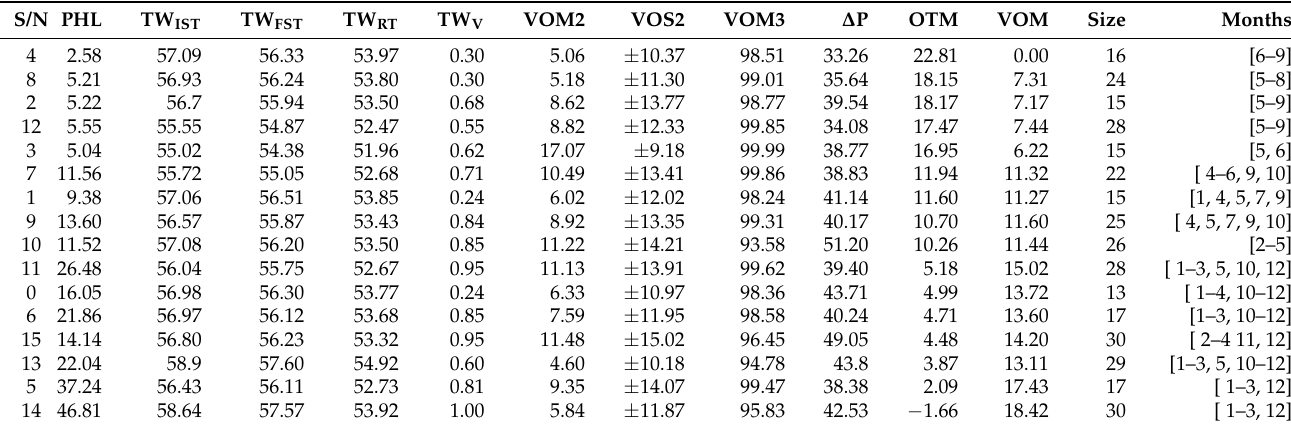
Table 14. Closed patterns from global model showing correlations between all three views after receiving chunk 2. Values are sorted based on OTM followed by TW V .